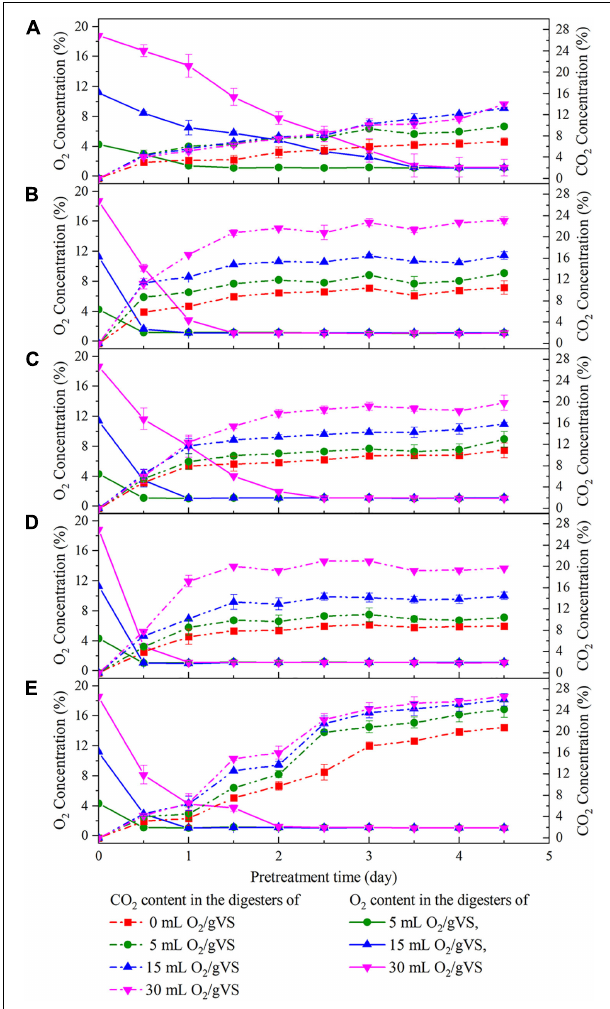
FIGURE 2 | Changes of O 2 and CO 2 concentration in the digesters during the pretreatment by CI (A) , SI (B) , CM (C) , SM (D) , and DE (E)